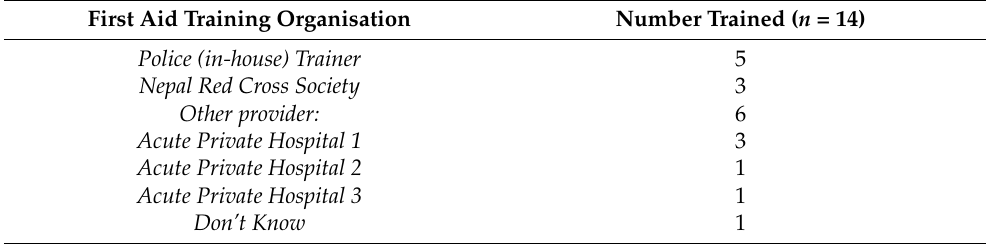
Table 1. Organizations Providing First-Aid Training to the Traffic Police in the Study District.